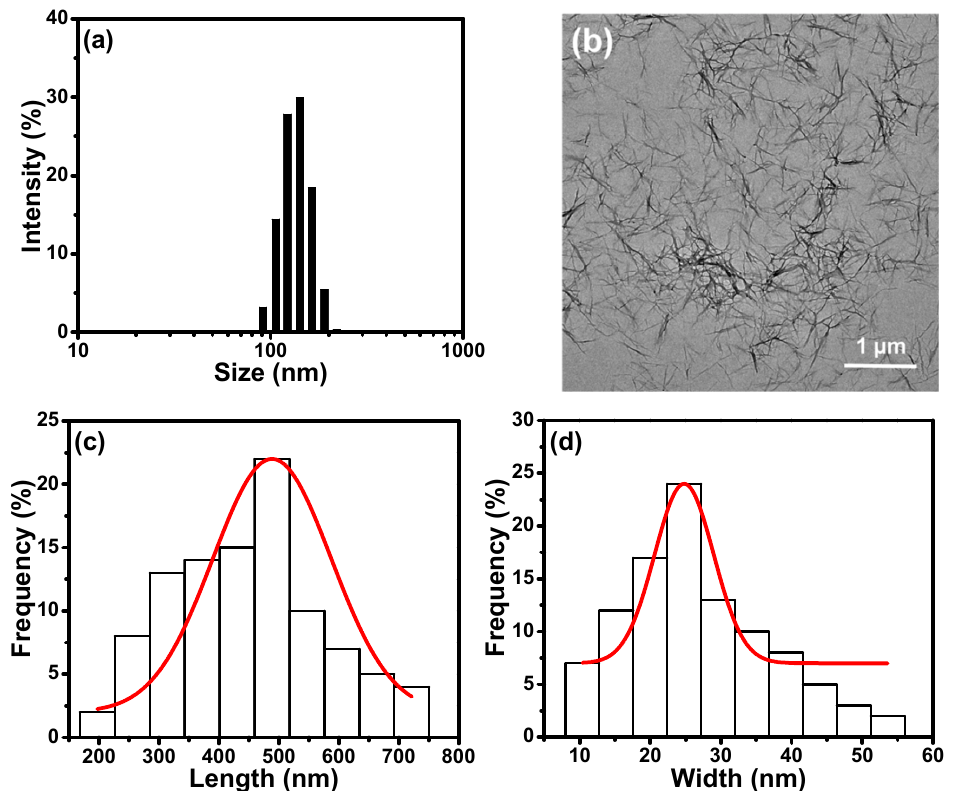
Figure 3. Characterization of the TCNFs: ( a ) The zeta size distribution, ( b ) TEM image, ( c ) length, and ( d ) width distribution of TCNFs.